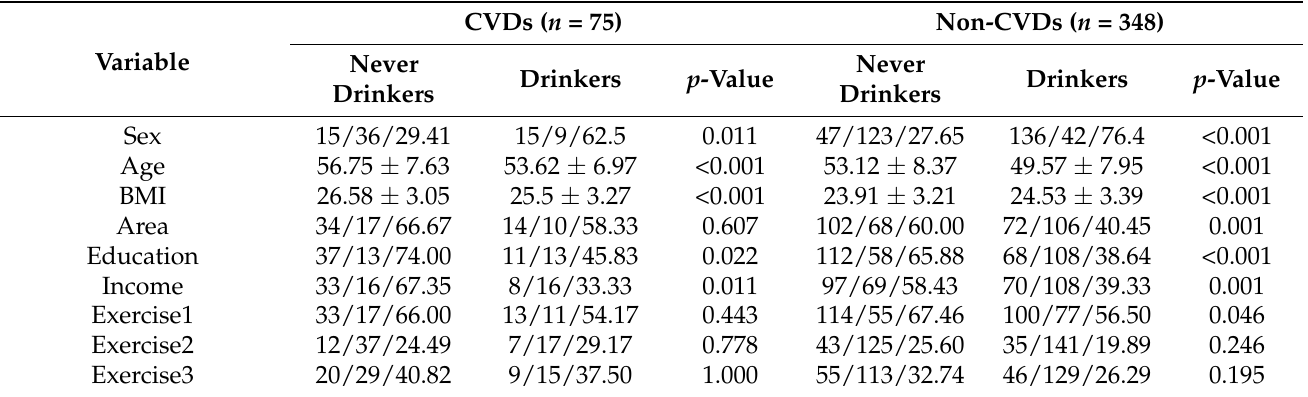
Table 2. Basal characteristics of participants classified according to drinking and chronic cardiovascu- lar diseases (CVDs) for methylation